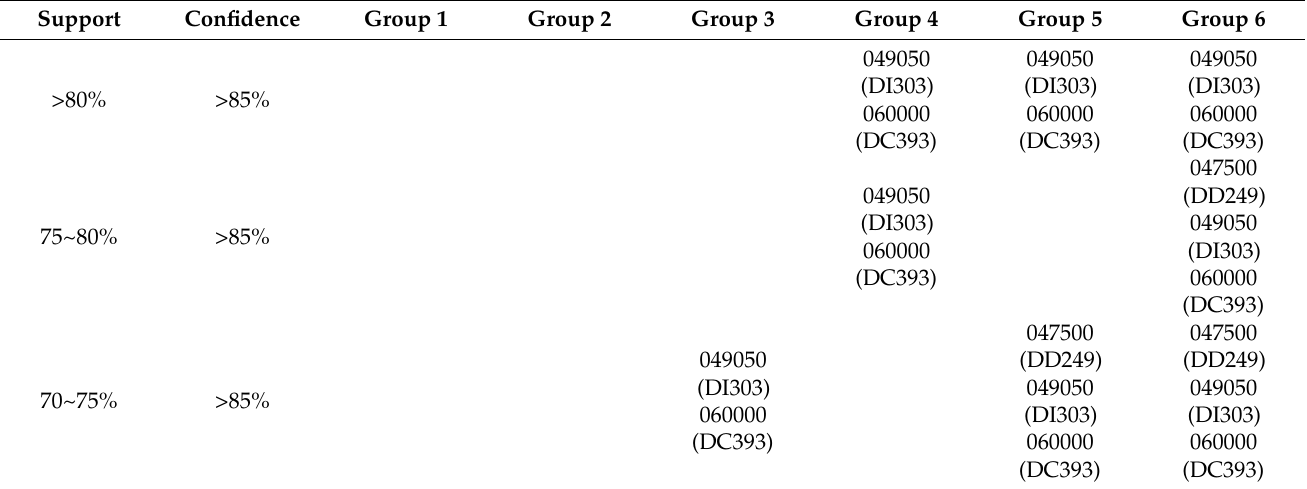
Table 3. Results of association rules using k-times standard deviation